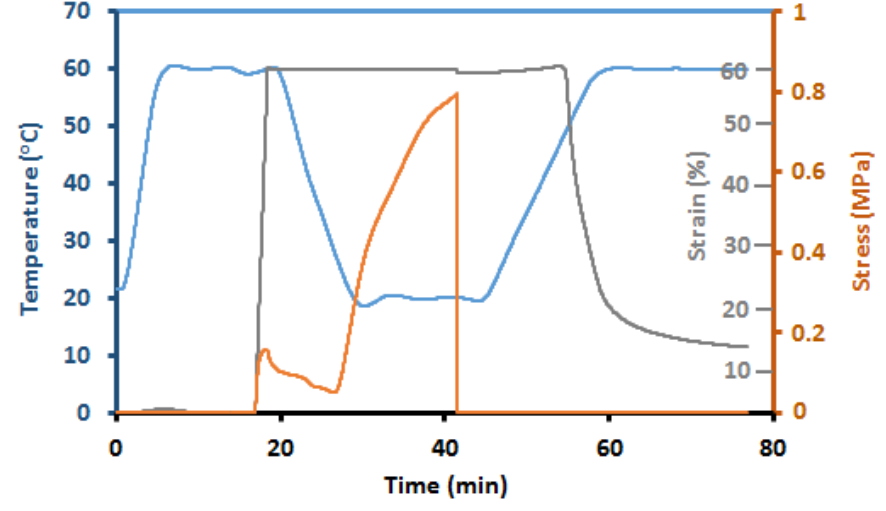
Figure 8. Temperature versus time, strain versus time (shape recovery) and stress versus time curves for PU 4 at 60 °C with an initial strain of 60%.